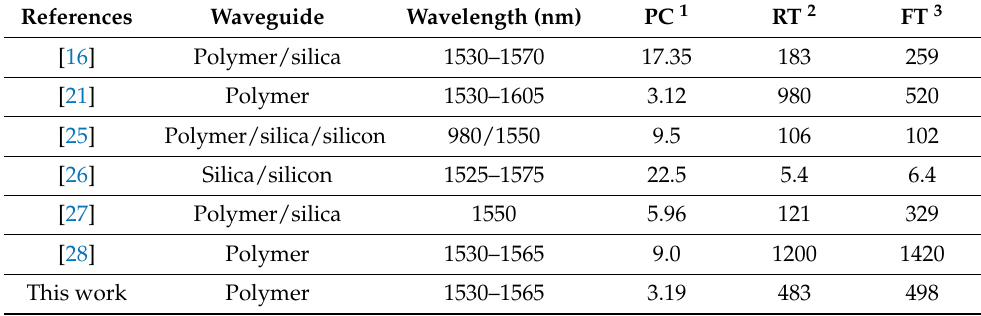
Table 4. Comparison of the proposed mode switch with the other reported switches.